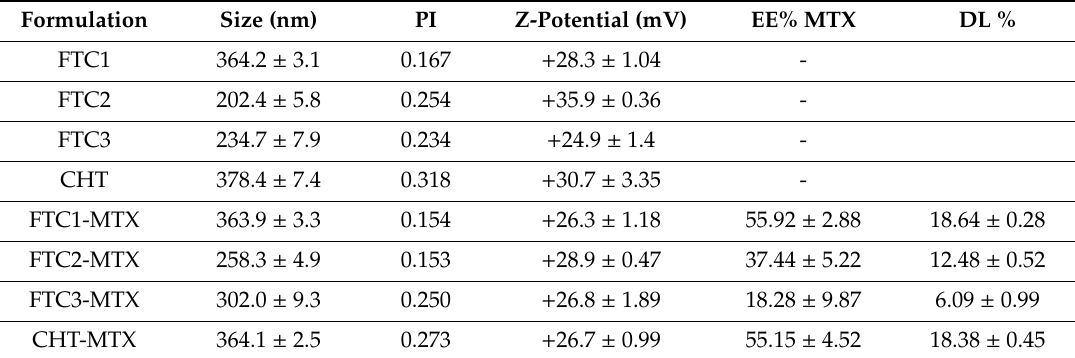
Table 2. The mean hydrodynamic diameters ranged between 202 nm and 378 nm, in good agreement with those evaluated by TEM